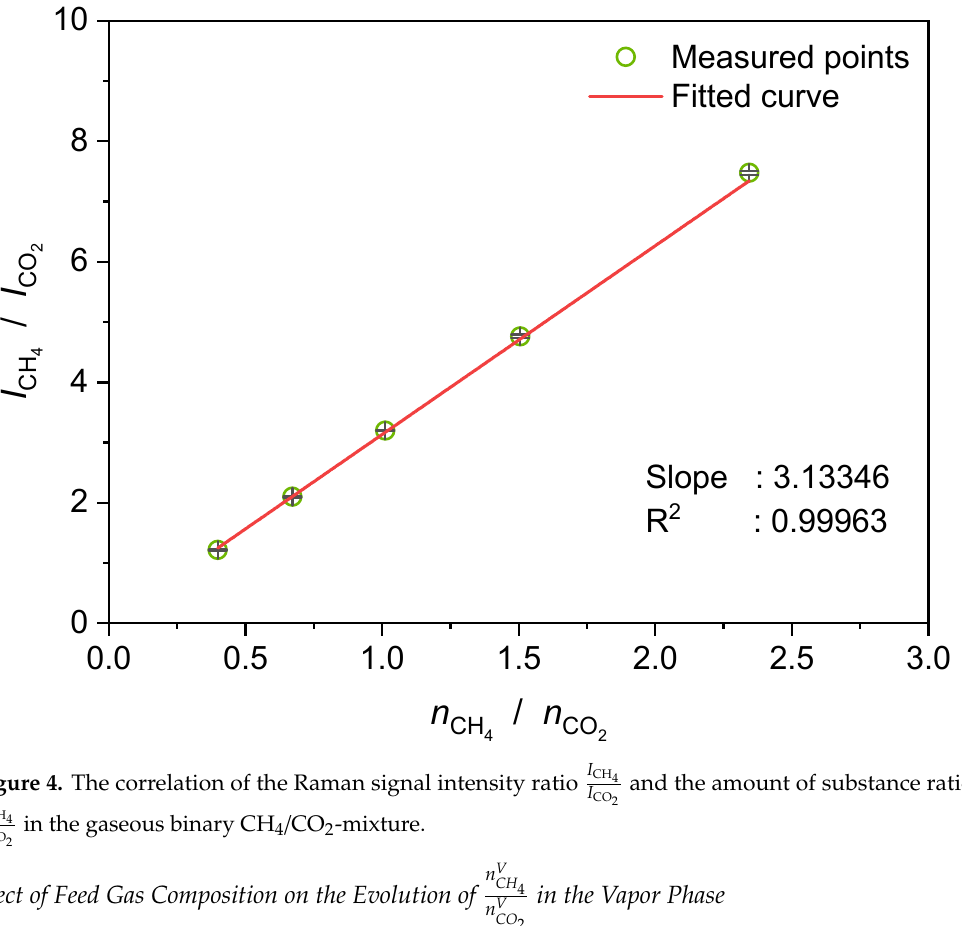
I CH4 and the amount of substance ratio (cid:3010) (cid:3135)(cid:3140)(cid:3120) I CO2 and the amount of substance ratio (cid:3010) (cid:3135)(cid:3147)(cid:3118)